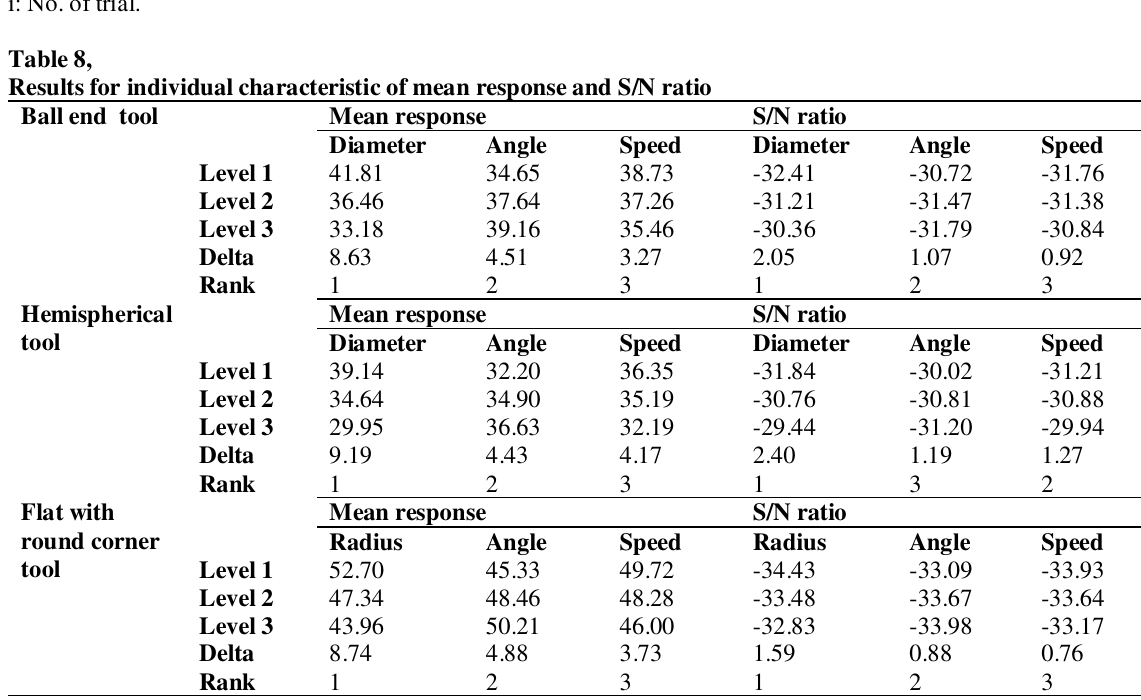
relationship mean response (Residual